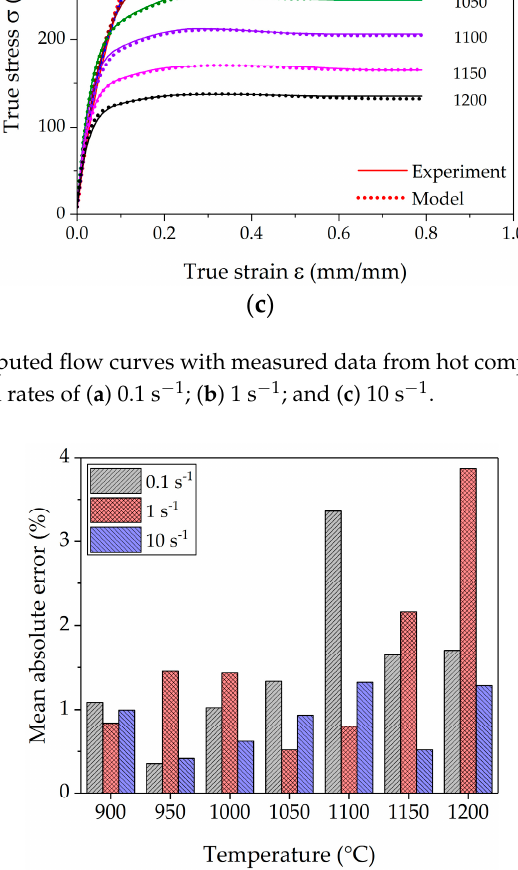
Figure 9. Mean absolute percentage error of the new model.